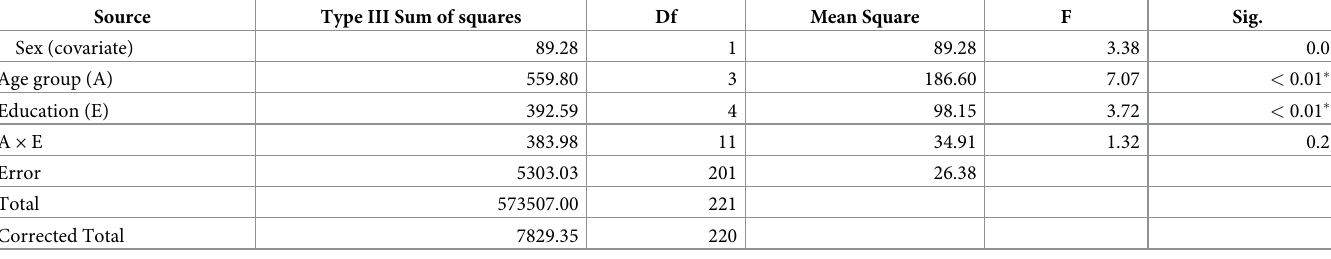
Note. �� indicates p < 0.01.